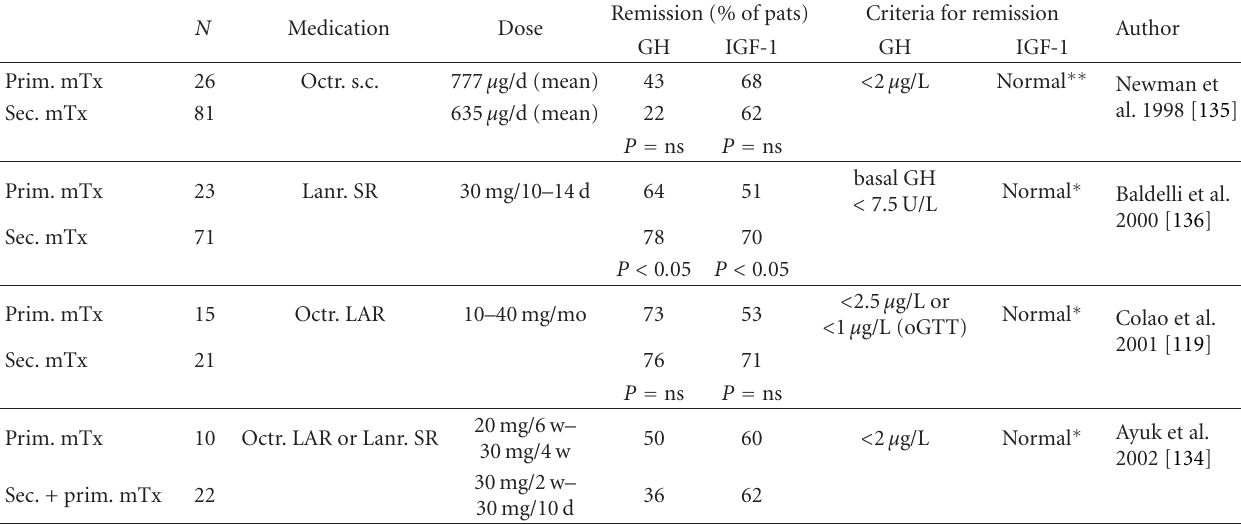
Table 3: Comparison of primary versus secondary medical therapy